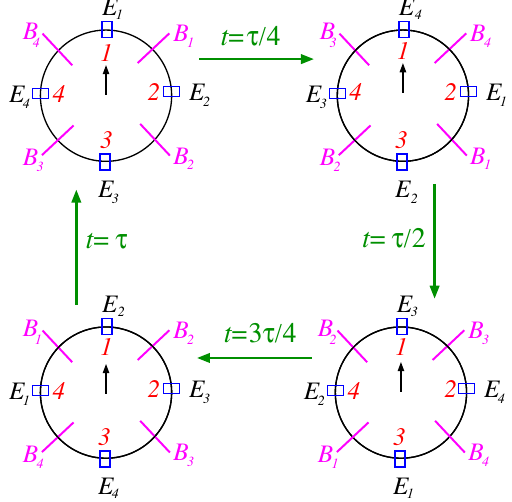
FIG. 2. Illustration of the deterministic protocol for N ¼ 4 . The red numbers 1, 2, 3, and 4 on the inner cycle denote the position in the clock, with the black arrow marking i ¼ 1 throughout. The energies E α and the energy barriers B α rotate one step in the clockwise direction after a time interval τ =N , as indicated by the long green arrows. For the variable α , these changes represented by the long green arrows correspond to an effective backward transition. For example, in the change from the top left to the top right that happens at time t ¼ τ = 4 , the variable i ¼ 1 remains fixed, and the variable α changes from α ¼ 1 to α ¼ 4